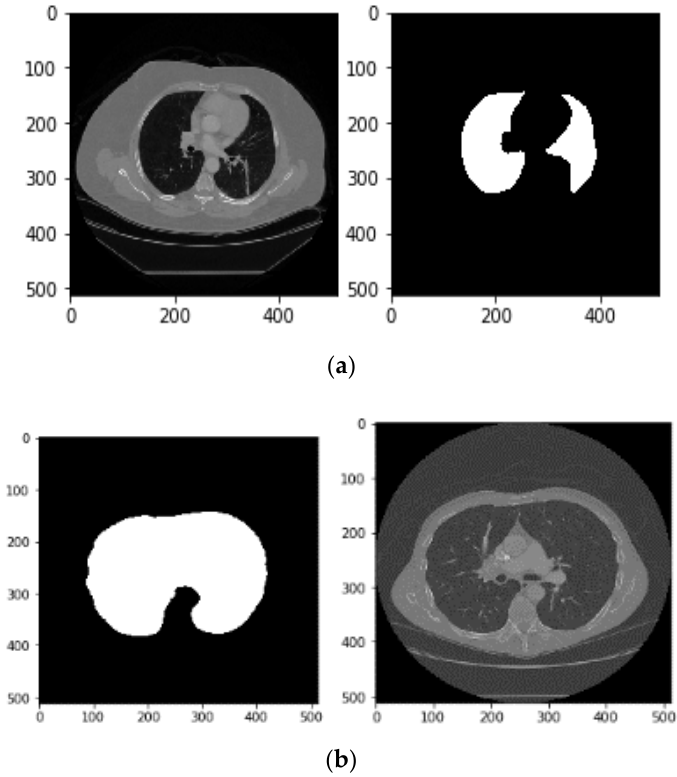
Figure 7. ( a ). Sample of missing a part of the lung in the generated mask, due to considering only the two largest areas, ( b ). Sample of misplaced pixels connecting that fills the non-pulmonary space with white pixels.